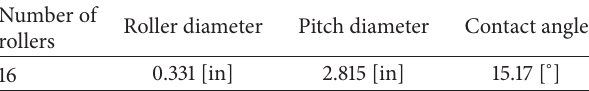
Table 2: Parameters of bearing Rexnord ZA-2115.